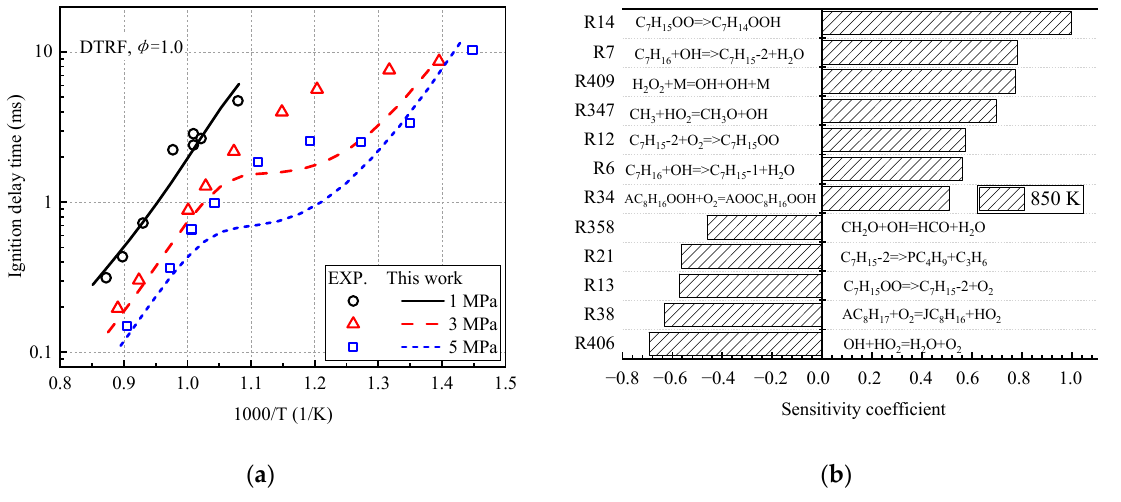
Figure 6. Prediction of ignition delay time and temperature-sensitivity coefficient of DTRF fuel. ( a ) Prediction of ignition delay time and ( b ) temperature-sensitivity coefficient.